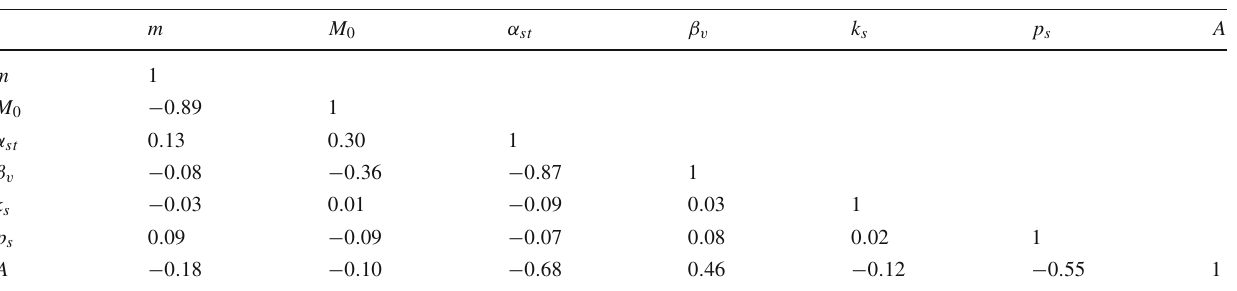
Table 3 Correlation matrix for the parameters of potential